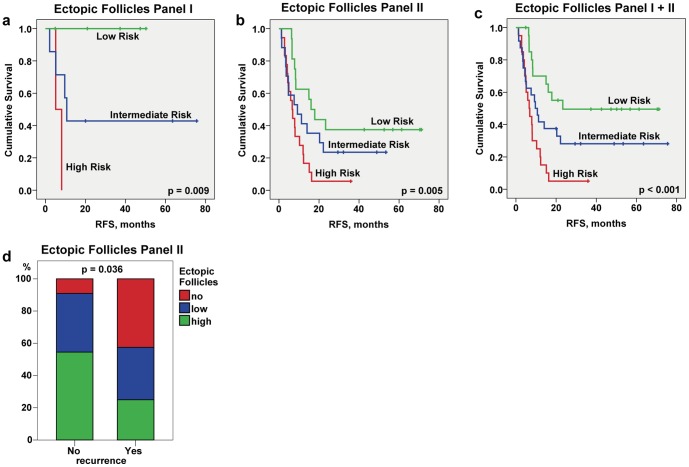
Prognostic effect of ectopic follicular structures allocated at the tumor – liver border.Kaplan-Meier estimates for patients stratification based on the ectopic follicle score at the border (a–c). Kaplan-Meier curves for RFS for panel I, panel II, and panel I+II show patient stratification into low (high number of follicular structures), intermediate (low number of follicular structures) and high risk (no follicular structures) groups; p value of the log-rank trend test is indicated. Panel I: low risk n = 5, intermediate risk n = 7, high risk n = 2; panel II: low risk n = 16, intermediate risk n = 17, high risk n = 18; panel I+II: low risk n = 21, intermediate risk n = 24, high risk n = 20. (d) Comparative assessment of contribution of no, low, and high ectopic follicle score to the total quantity for patient sub-groups without (No) and with (Yes) disease recurrence as estimated at the time point of 24 months where no censoring has occurred; p value of chi-square trend test is shown.